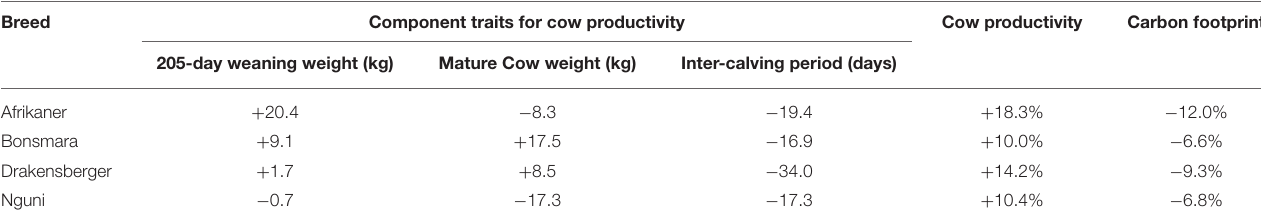
TABLE 3 | The phenotypic changes in the component traits of cow productivity, cow productivity, and the carbon footprint in the four landrace breeds. Breed Component traits for cow productivity Cow productivity Carbon footprint Mature Cow weight (kg) Inter-calving period